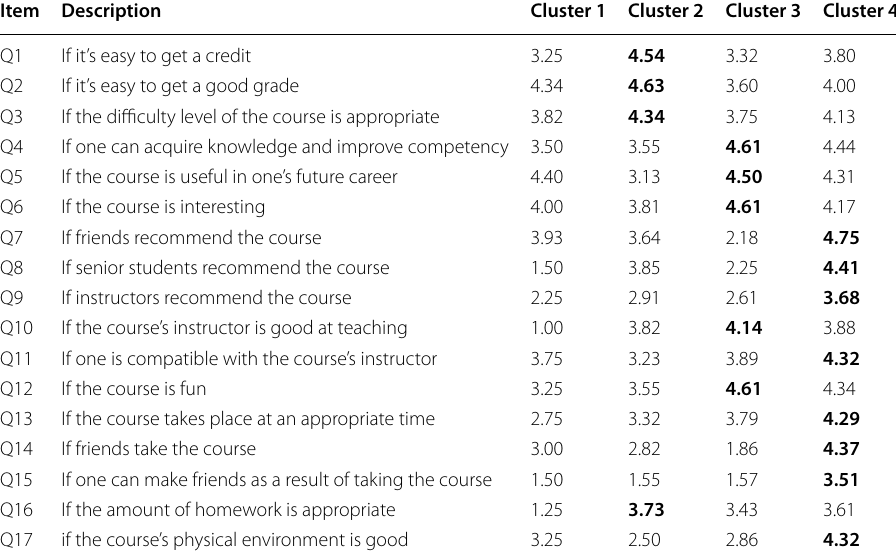
The largest value in each row is highlighted with bold